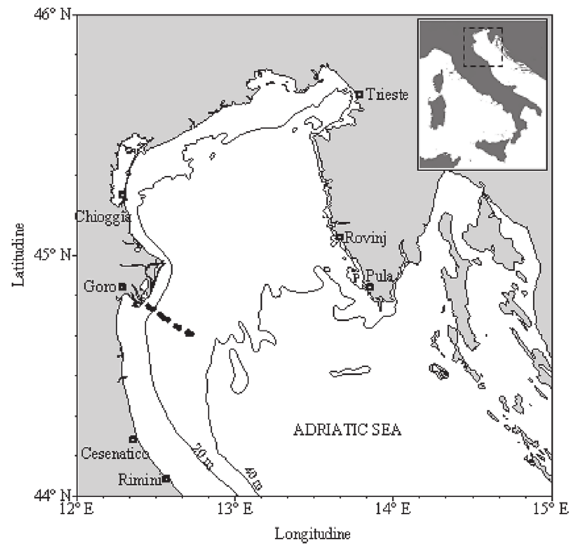
Fig. 1. – study area, showing sampling stations ( ò ) along the transect.